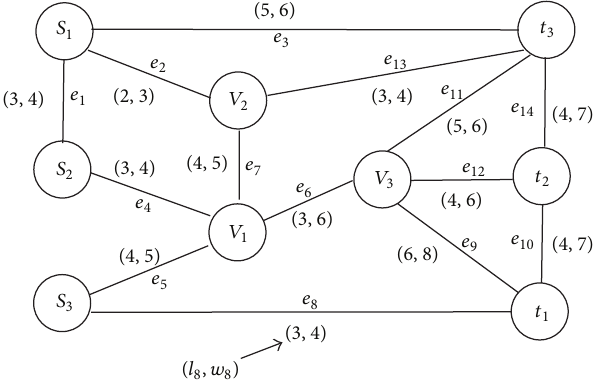
Figure 3: An example of the SPIUH